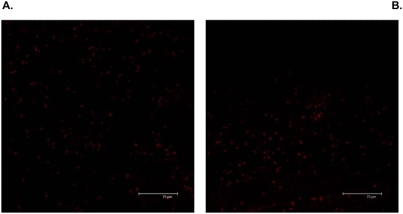
Fluorescence Detection of apoptotic cells.Panel A shows apoptotic cells (stained in red with the ApopTag kit) in a skin section of a mouse infested with a Ir-LBP siRNA-treated tick. Panel B shows apoptotic cells stained with the same technique in a skin section from a mouse infested with a siControlRNA-treated tick.